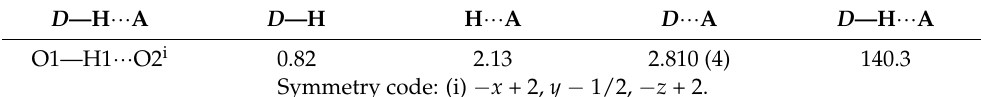
Table 2. Hydrogen bond geometry of 1 (Å, °).